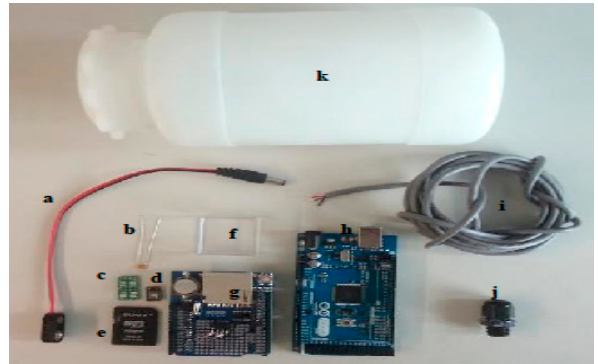
Figure 3. KdUINO components, ( a ) 9 V Battery button power plug for Arduino; ( b ) 100 nF Capacitor;